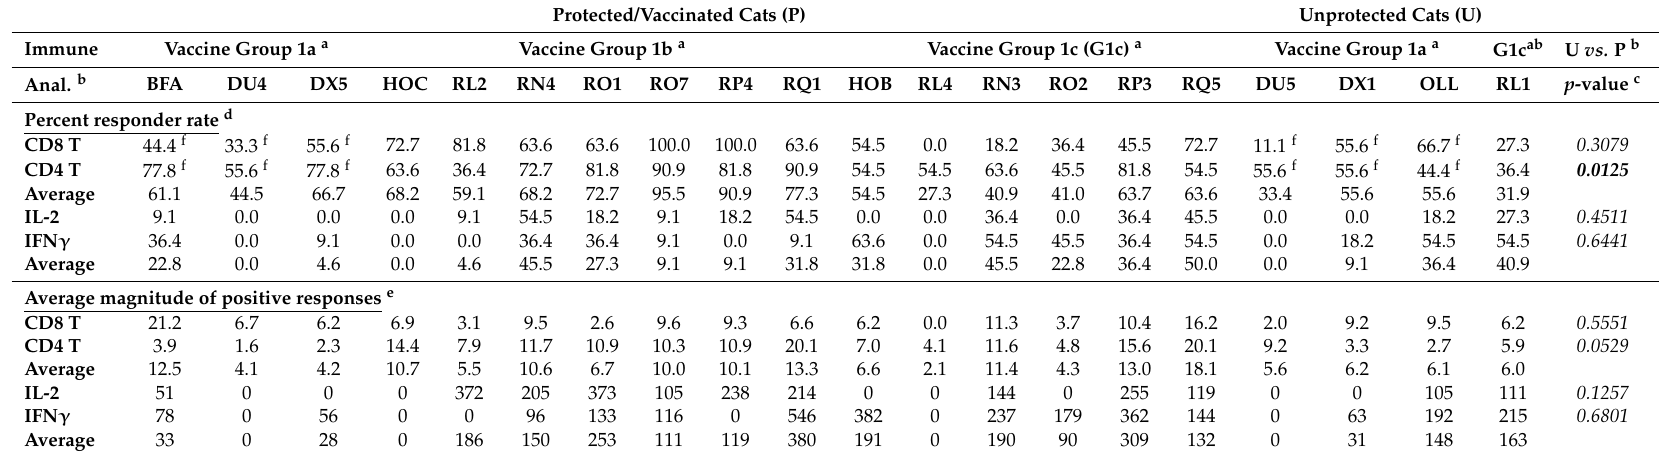
Table 5. Responder rate and average magnitude of the immune responses of individual vaccinated cats at six weeks post-third vaccination. Protected/Vaccinated Cats (P) Unprotected Cats (U) Immune Vaccine Group 1a a Vaccine Group 1b a Vaccine Group 1c (G1c) a Vaccine Group 1a a G1c ab U vs. P b Anal.